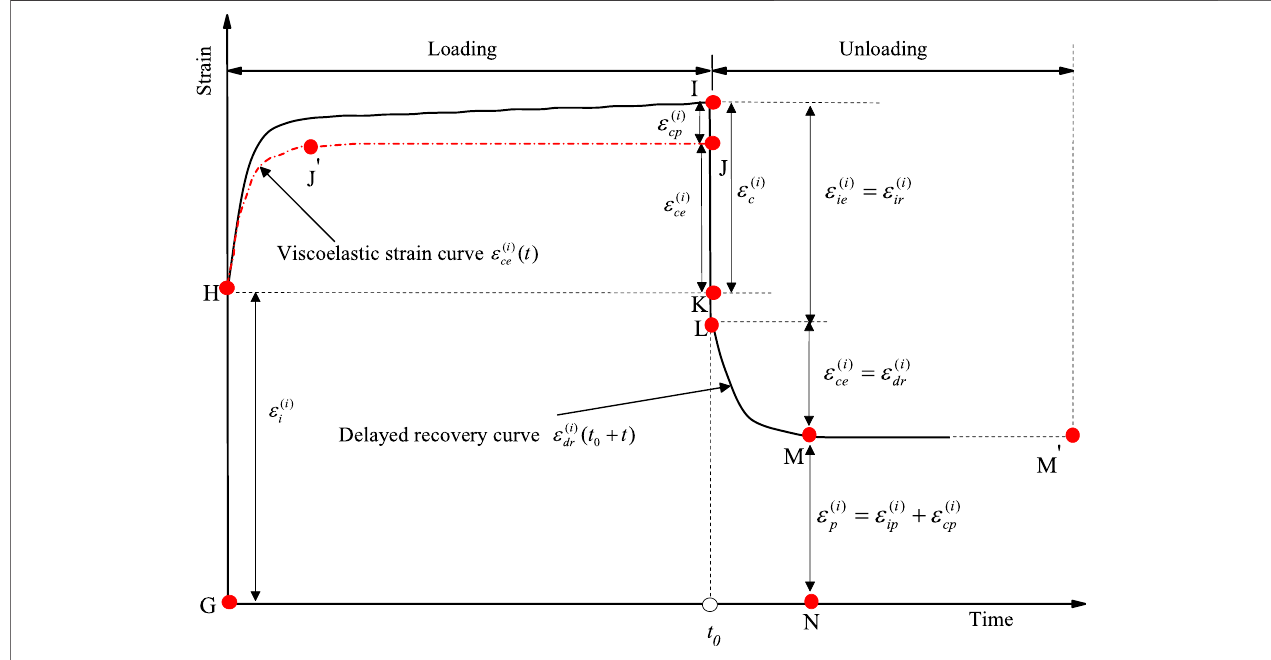
FIGURE 6 | Viscoelastic-plastic strain separation diagram (Zhao et al., 2017b).